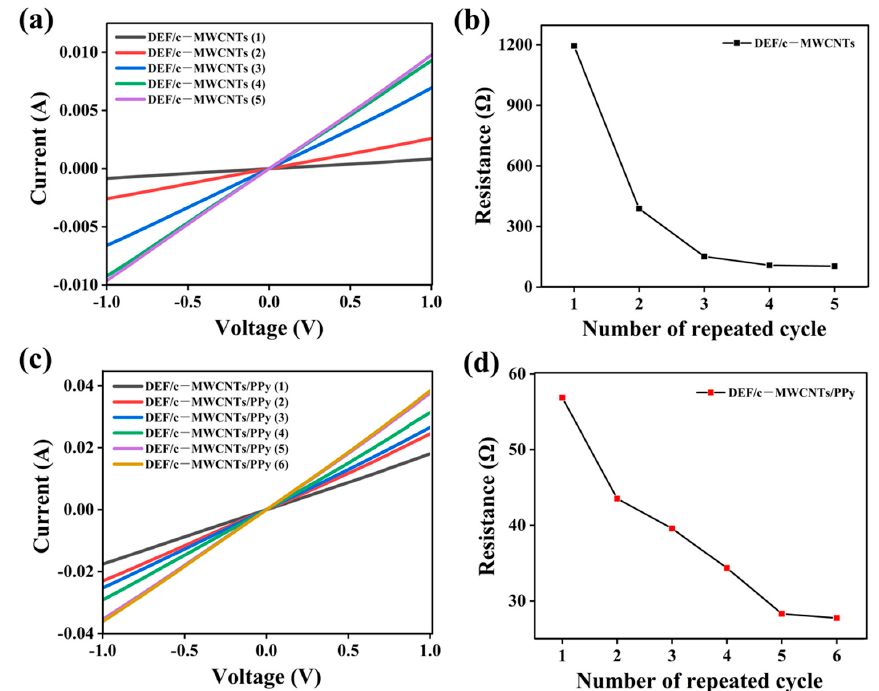
Figure 5. ( a ) The I–V plots of DEF/c-MWCNTs with different c-MWCNTs soaking cycles; ( b ) The relationship between resistance and the number of c-MWCNTs soaking cycles. ( c ) The I–V plots of DEF/c-MWCNTs/PPy with different of adsorption-oxidizing cycles of the PPy precursor; ( d ) The relationship between resistance and the number of adsorption-oxidizing cycles.